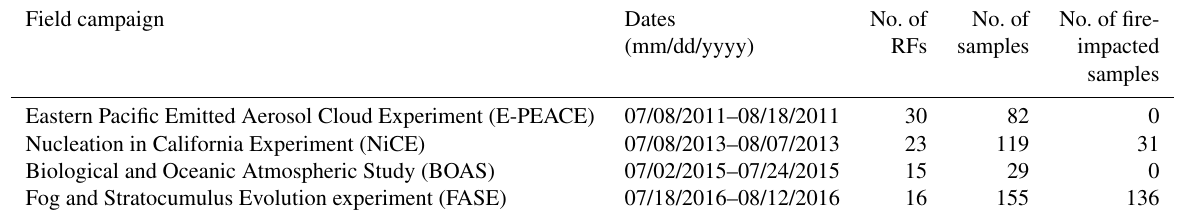
Table 1. Summary of field campaign data sets used in this study and statistics related to cloud water sample collection. Smoke-influenced research flights (RFs) were NiCE RFs 16–23 and FASE RFs 3–11 and 13–15. Field